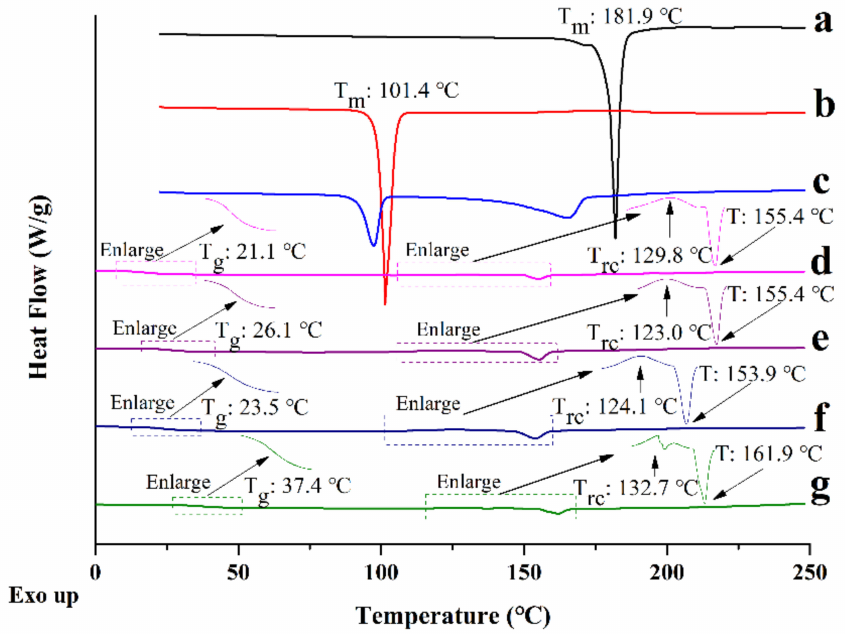
Figure 3. DSC thermograms: ( a ) crystalline CUR; ( b ) crystalline MAG; ( c ) CUR-MAG PM; ( d ) CUR-MAG CM; ( e ) CUR-MAG-HPMC CM; ( f ) CUR-MAG-HPC CM; ( g ) CUR-MAG-PVP K30